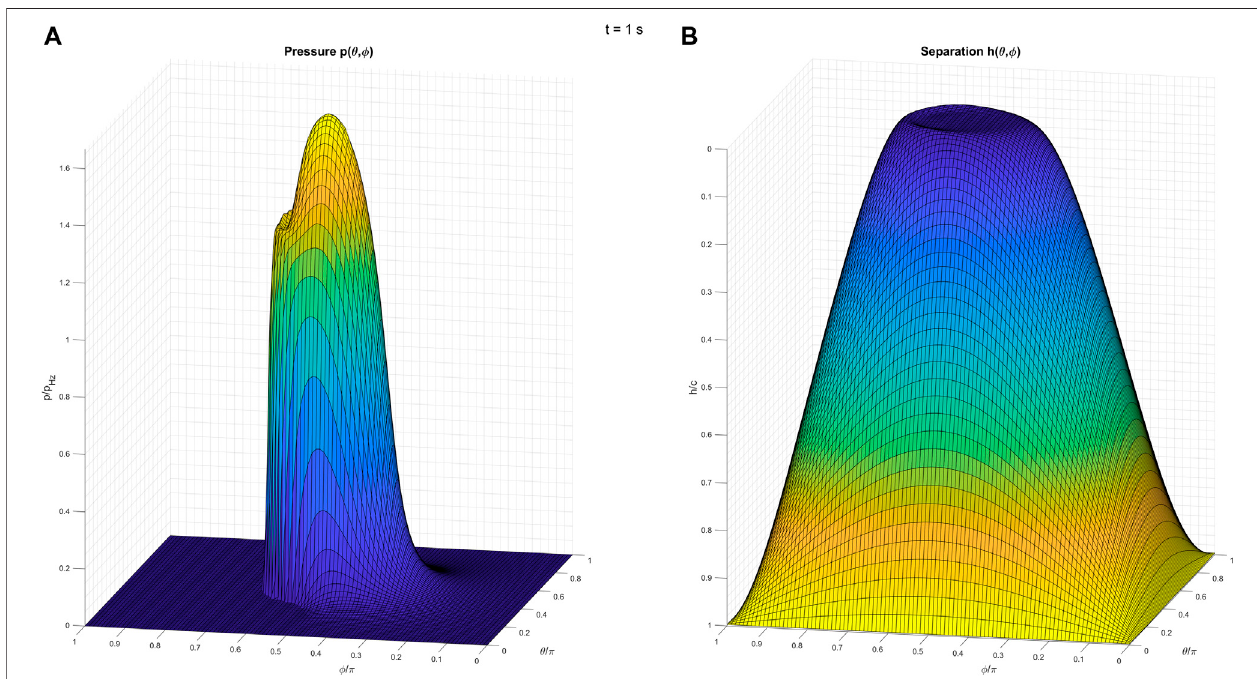
FIGURE 6 | Lubricant pressure (A) and surface separation (B) fi elds.